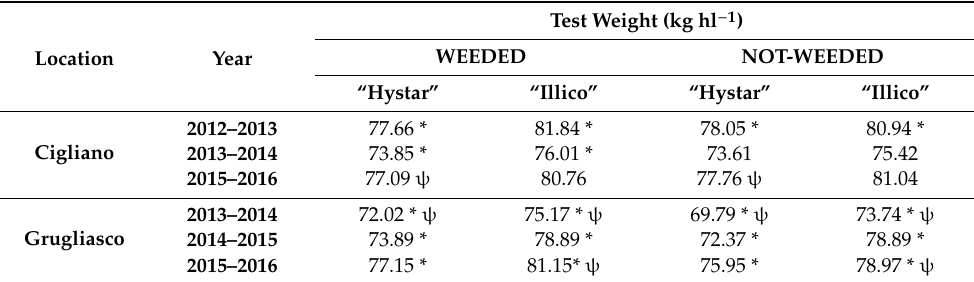
Table 7. Test weight measured at the harvest in the two locations.